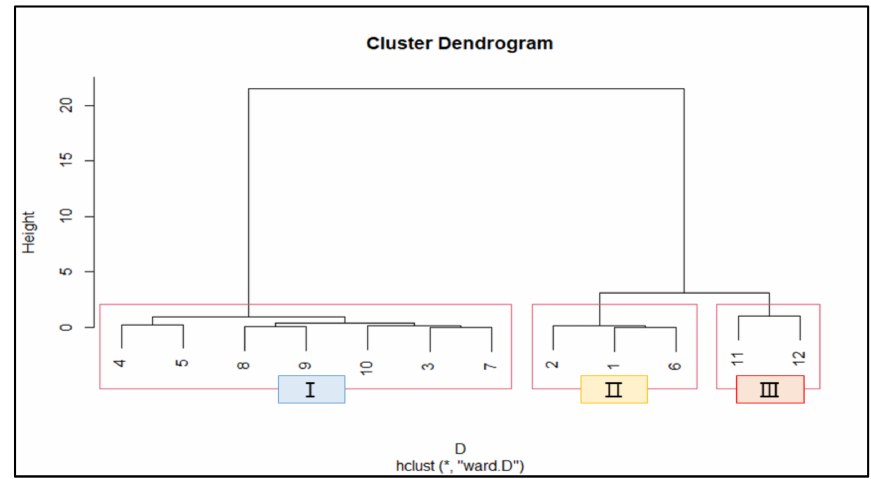
Figure 9. Result of the collapsed reservoirs using cluster analysis.